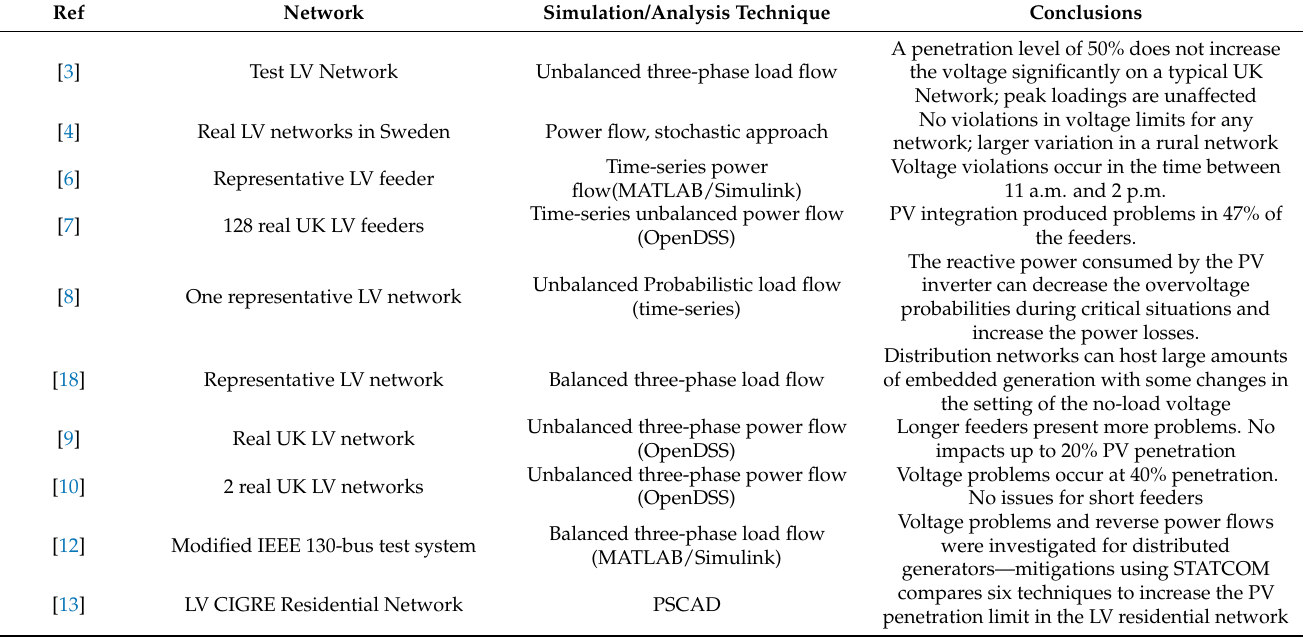
Table 1. Summary of PV impact